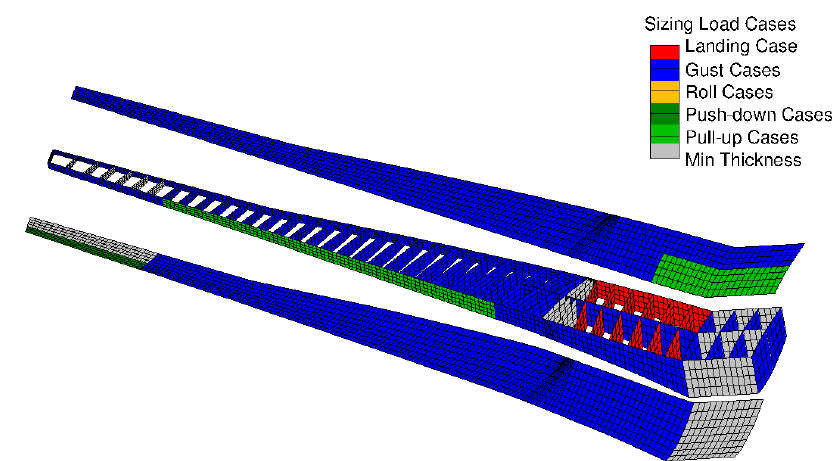
Figure 19. Bending moment envelope of the reference aircraft.